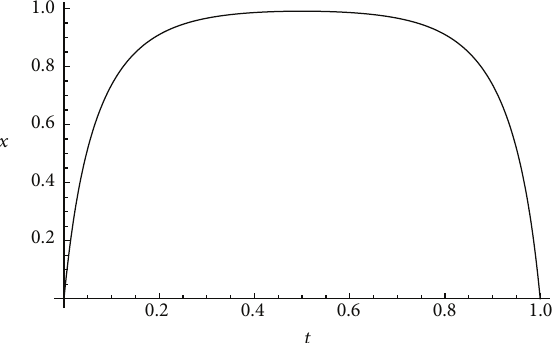
Figure 9: The graph of the function 𝑈(𝛼,0.02) .